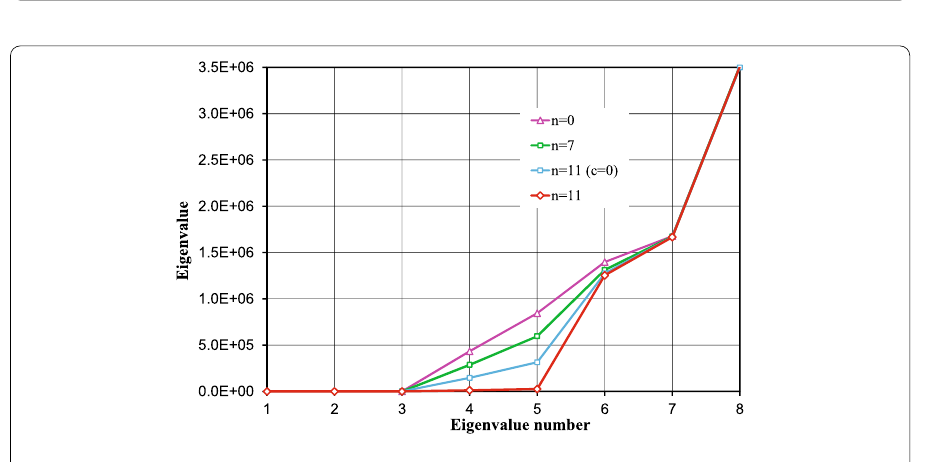
Fig. 5 Eigenvalues of the distorted flat element